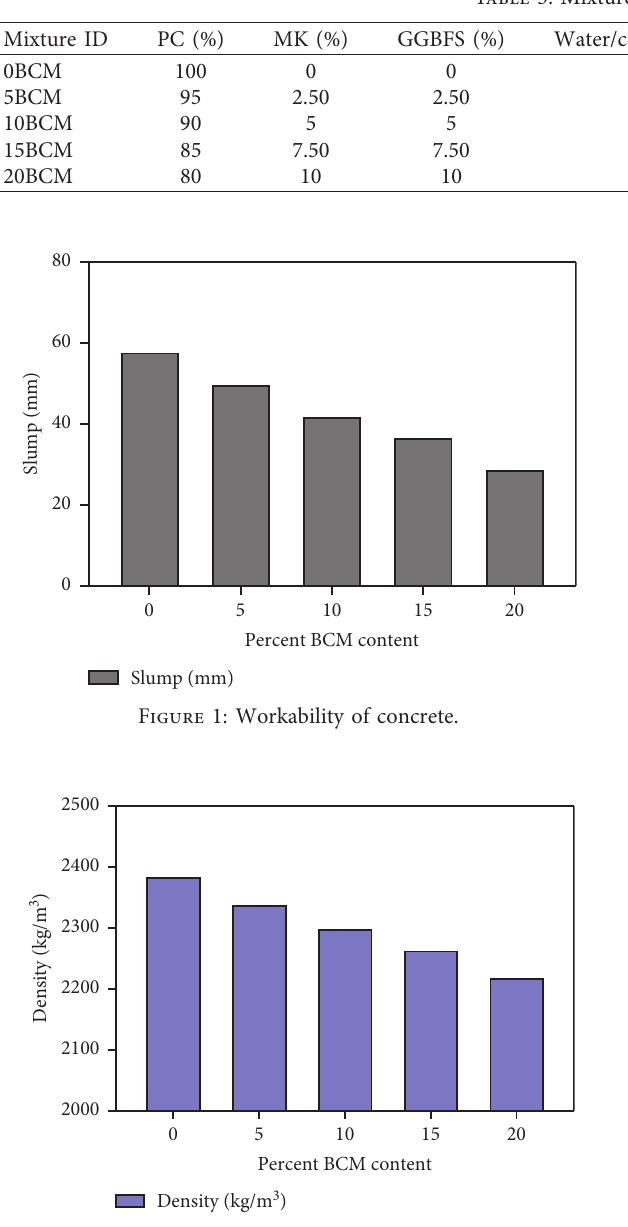
Figure 2: Density of concrete after 28days.